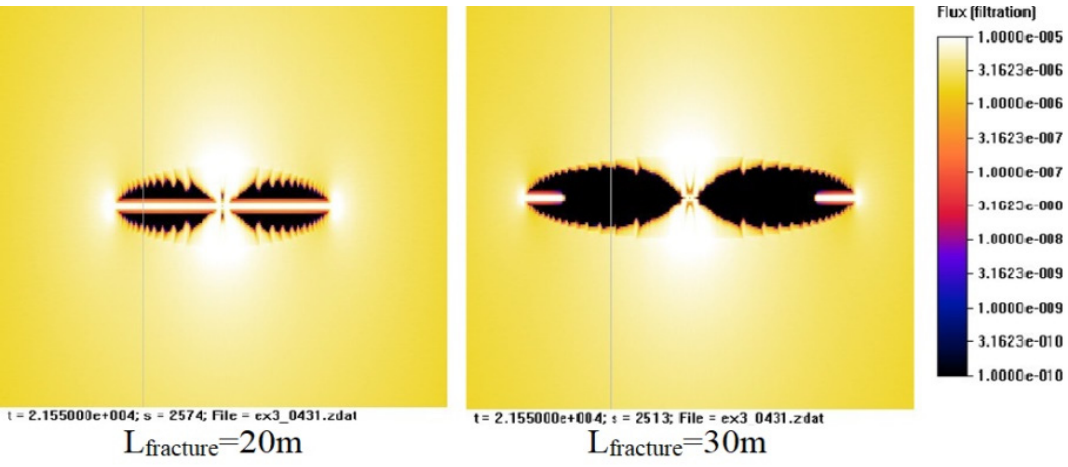
Figure 28. Oil seepage velocity approximately 6 h after the start of cleaning.